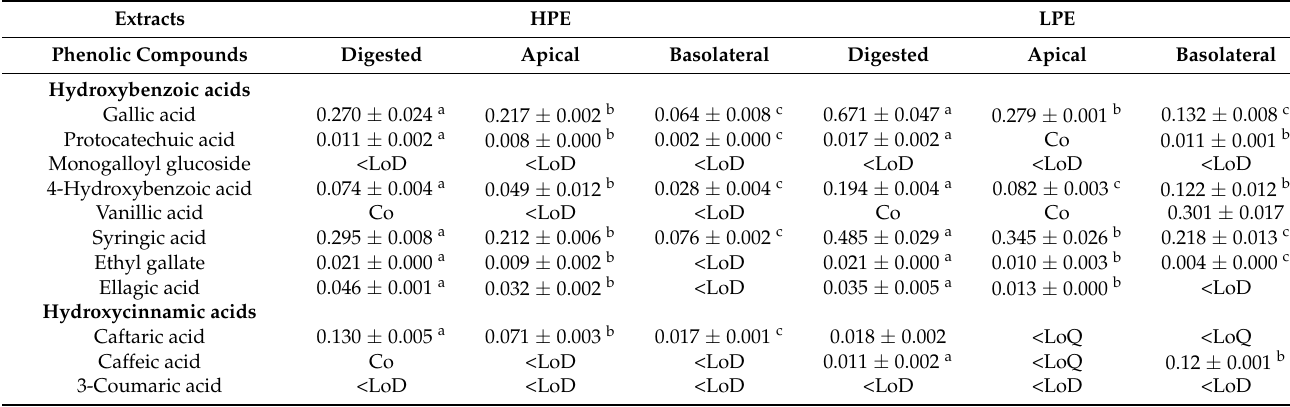
Table 5. Phenolic compounds recovered from the apical (unabsorbed) and basolateral (bioavailable) compartments during the uptake experiment conducted on Caco-2 cell monolayers (mg compound/g of